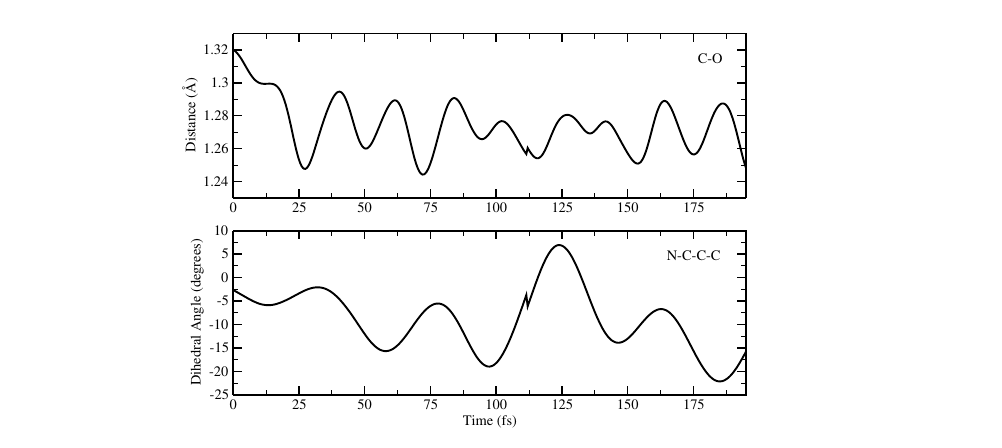
Figure 18. Time evolution of the CO(tyr) distance and N-C-C-C dihedral angle of the